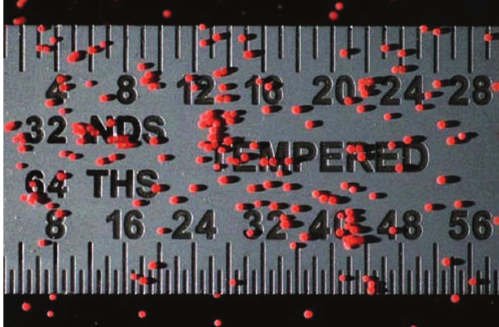
Figure 10: Healing-agent-containing microcapsules used in self- healing polymers. A steel ruler is pictured in the background for reference (Magnus Andersson, University of Illinois).